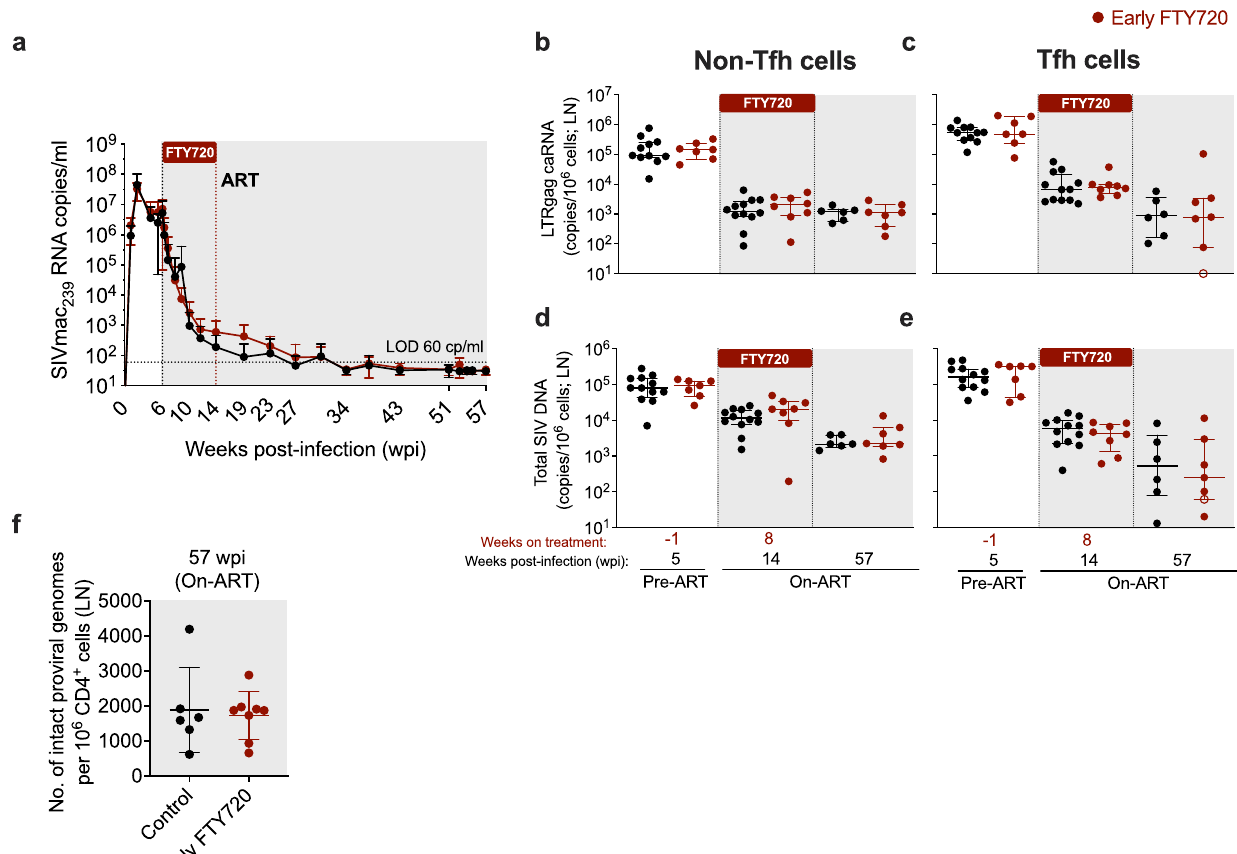
Fig. 3 | FTY720 treatment in the fi rst weeks of ART does not reduce plasma viremia or levels of cell-associated SIV-RNA or SIV-DNA in LN. a Plasma viral loads (SIVmac 239 RNA copies/mL) measured by qRT-PCR longitudinally in early FTY720orcontrolSIV-infectedRMsuntil57weekspost-infection(wpi).Thedashed horizontal line represents the assay ’ s limit of detection (LOD; 60 copies/mL) with undetectableeventsplottedas30copies/mL. b , c Cell-associatedSIV-RNA(LTRgag caRNA; copies/10 6 cells) and ( d , e ) cell-associated SIV-DNA (copies/10 6 cells) in sorted ( b , d ) non-Tfh and ( c , e ) Tfh CD4+ memory T cells derived from LN of early